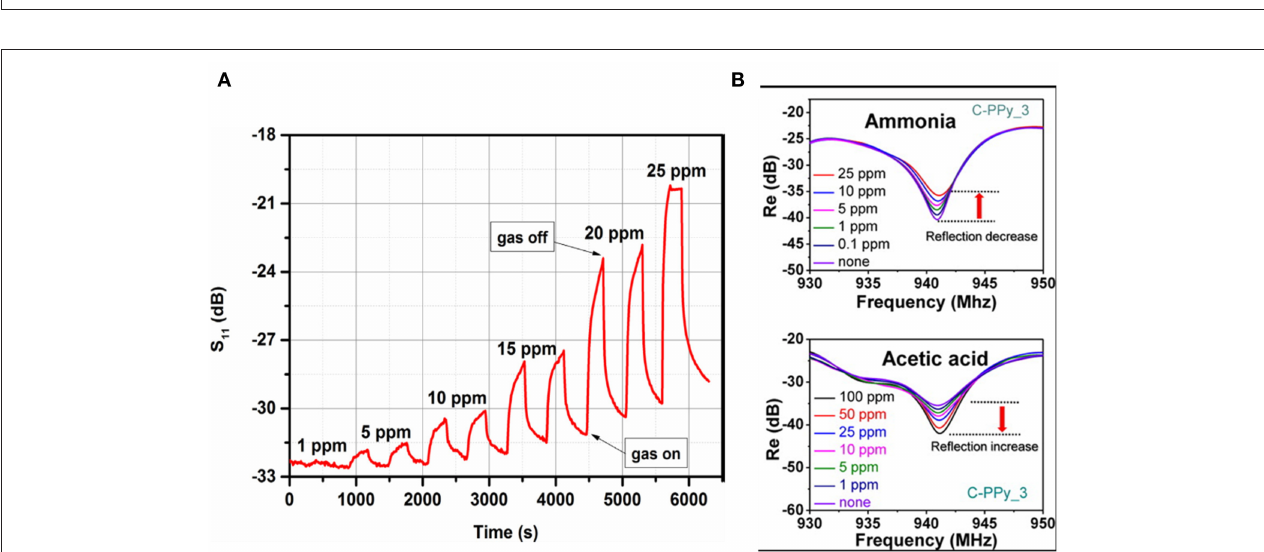
FIGURE 8 | (A) Magnitude of reflection coefficient S11 measured at the resonant frequency under exposure to acetone in the 0–25 ppm concentration range, (B) change in the reflectance properties of different concentrations of ammonia and acetic acid. Reproduced with permissions from Jun et al. (2016) and Staszek et al. (2017). Copyright 2017 Elsevier; copyright 2016 American Chemical Society.